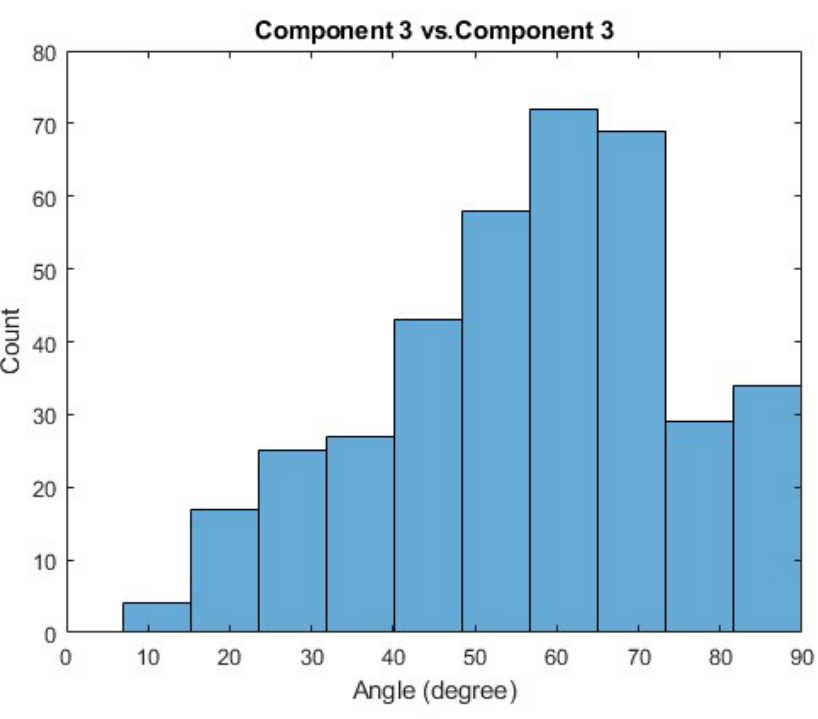
Figure A9. Histogram of the comparisons between the third principal component of some Trial A and the third principal component of some Trial B, where these comparisons are made across all trials and